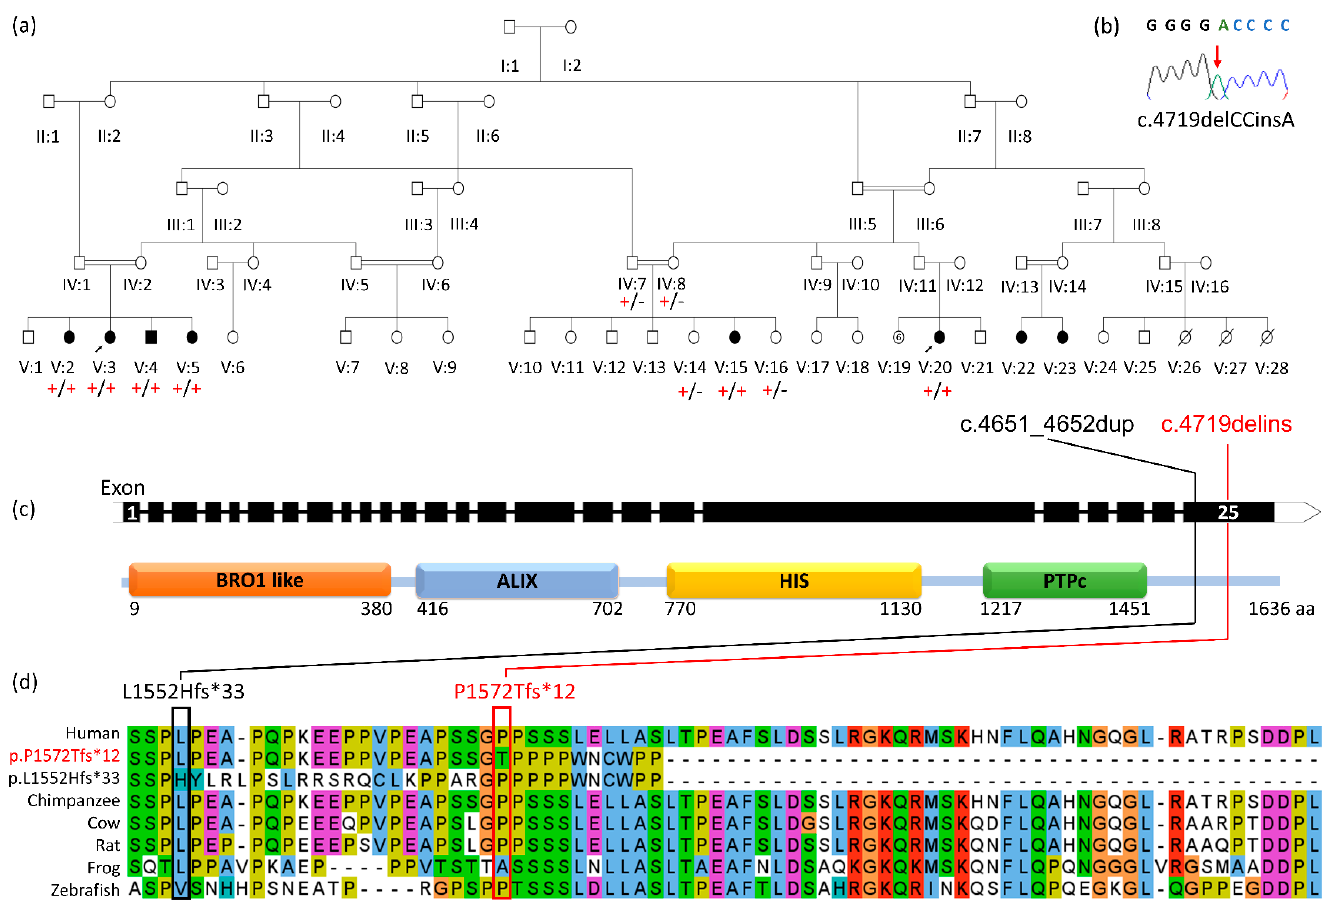
Figure 1. Truncating PTPN23 gene variants that escape nonsense-mediated decay are associated with complex spastic paraplegia: ( a ) simplified pedigree of the Arab Palestinian family investigated, demonstrating segregation of the PTPN23 variant [‘+’: NM_015466.3:c.4719delins p.(Pro1572Thrfs*12), ‘-’: wild type]. ( b ) Electropherogram revealing the DNA sequence of the PTPN23 NM_015466.3:c.4719delins variant in homozygous state in an affected individual (Individual V:4). ( c ) A simplified gene diagram showing exon-intron organisation of PTPN23 (NM_015466.3) and the corresponding domain architecture of the PTPN23 protein. The position of the NM_015466.3:c.4719delins p. Pro1572Thrfs*12 variant is shown [red line] in relation to the NM_015466.3:c.4651_4652dup; p.(Leu1552Hisfs*33) [14] [black line]. ( d ). PTPN23 protein alignment of human wild type and five species orthologues, alongside the predicted outcomes of the p.(Pro1572Thrfs*12) and p.(Leu1552Hisfs*33)